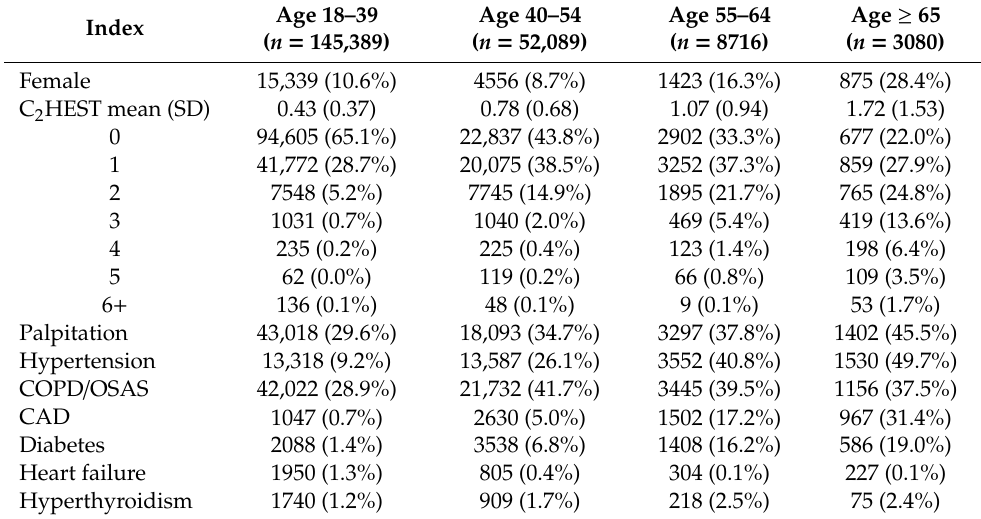
Table 1. Baseline characteristics of 209,274 subjects with C 2 HEST